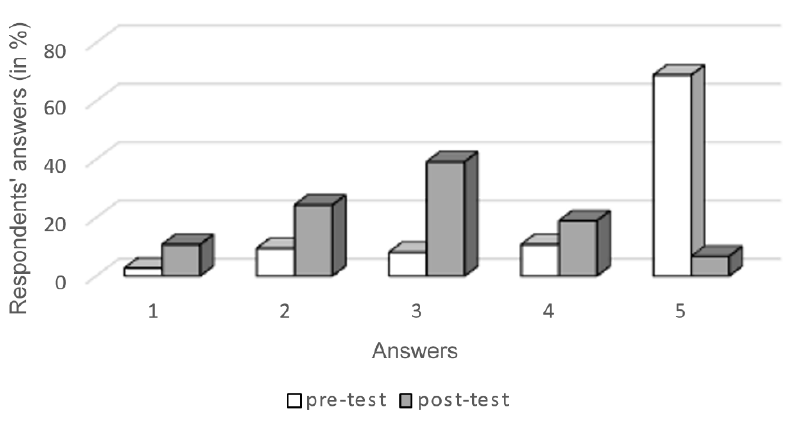
Figure 2. Respondents’ answers to question no. 1 (when learning algorithms, I consider it important to remember the algorithm as a whole) in pre-test and post-test